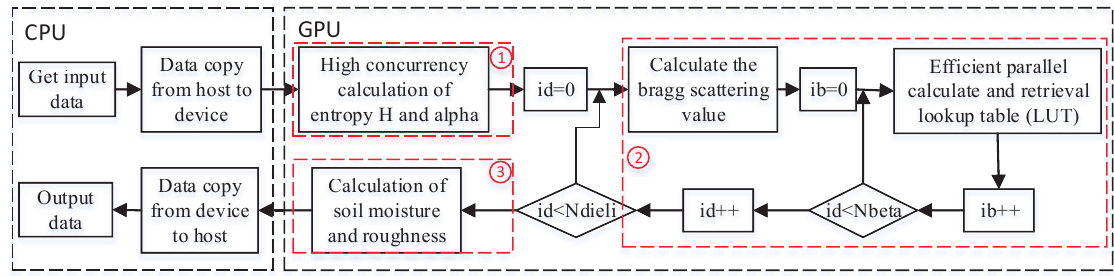
Figure 5. Optimization flowchart of the X-Bragg